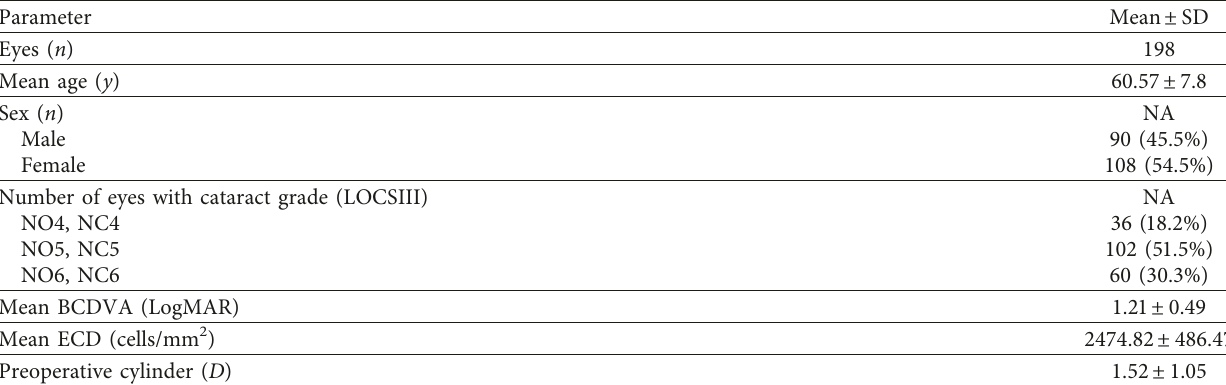
Table 1: Demographic data, preoperative data, and cataract grading of the patients.